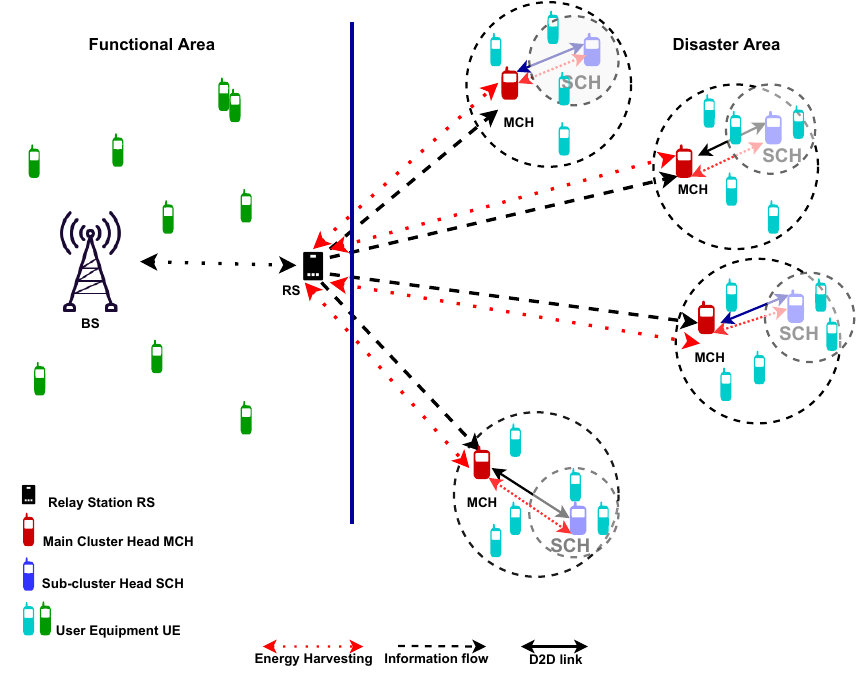
Figure 1. The proposed disasters network